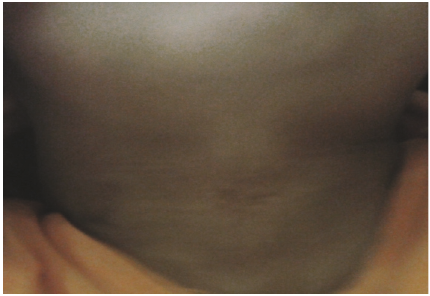
Figure 6: 18-month postoperative result in the same patient in Figure